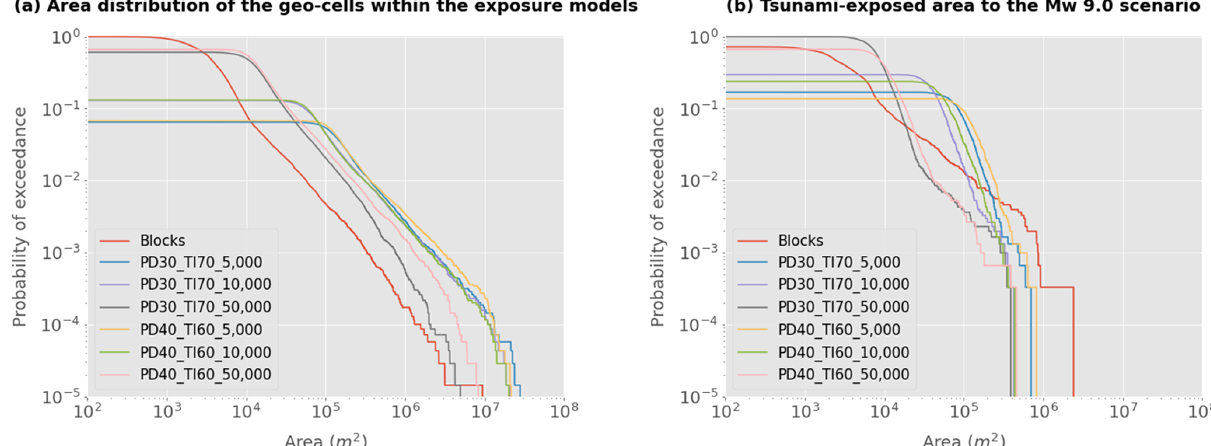
Figure 11. Variability in the area (in square metres) of the geo-cells that compose every aggregation area for exposure modelling, for (a) the entire urban area of Lima and (b) for the area for which tsunami-induced loss values were obtained for the M w 9.0 scenario. Seven models are evaluated: the official administrative block-based model and six CVTs. The percentages assigned to the two focus maps’ components (PD: population density and TI: tsunami inundation height) are written and are followed by the selected number of sampling seeding